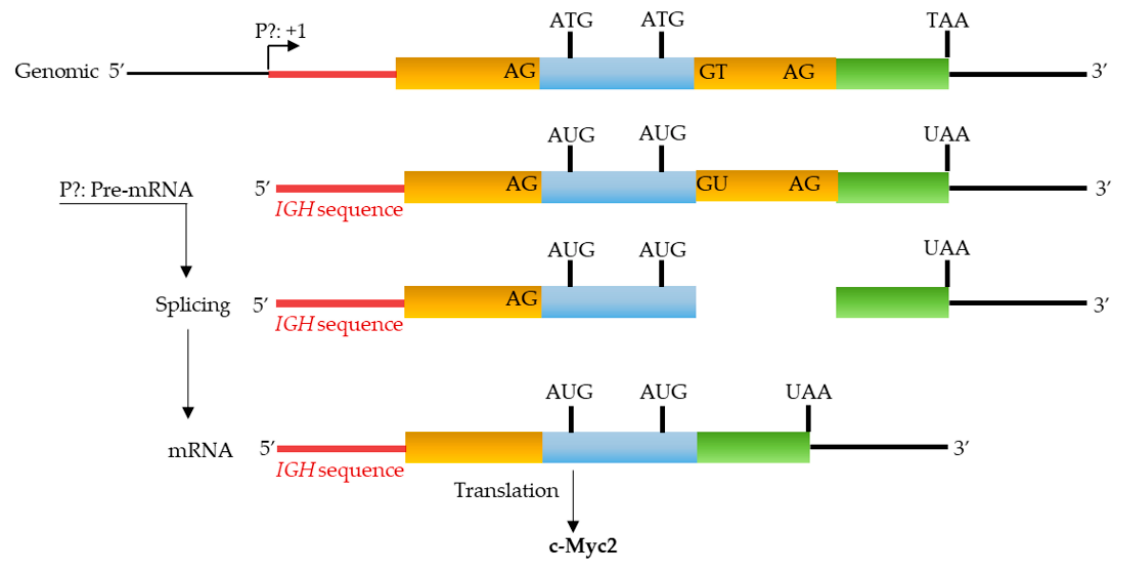
Figure 4. Partial genomic structure of the c-MYC gene that is associated with t (8;14) translocation of BL41. The expression from a yet to be determined promoter (P?) generates a hybrid mRNA with an IGH sequence. The translation of the resulting mRNA leads to the production of the c-Myc2 protein. Diagram is not to scale.